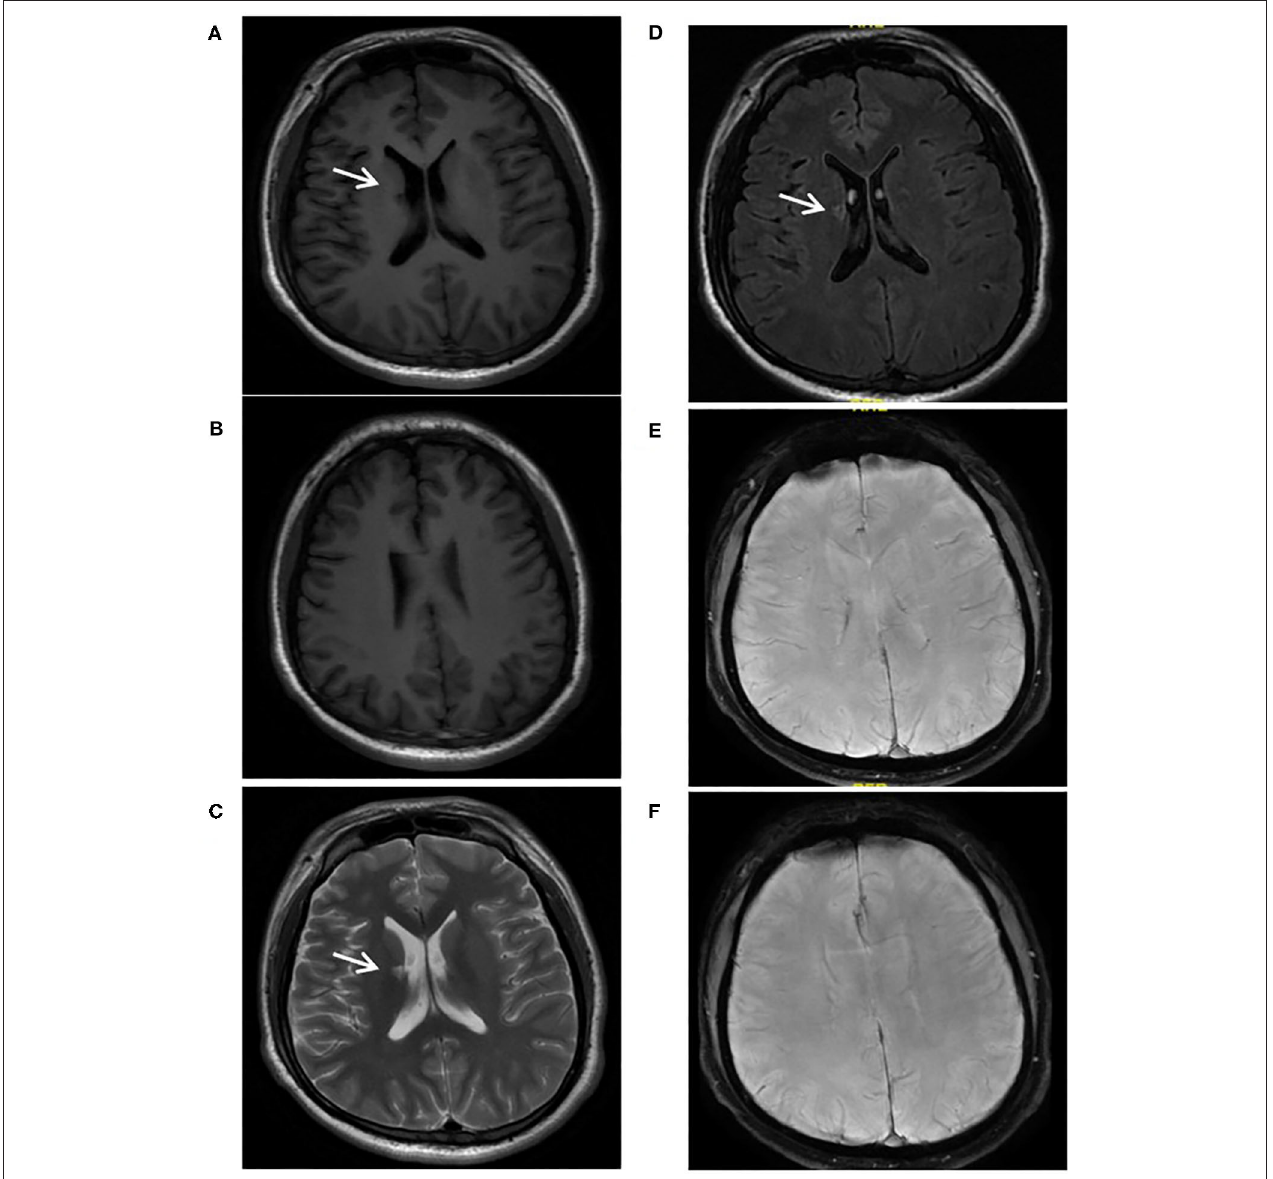
FIGURE 5 | A 24-year-old male with Sneddon’s syndrome (case 7) suffered livedo reticularis and ischemic stroke. A chronic lacune was observed in the right basal ganglion (A,C,D) . Neither chronic superficial siderosis nor cerebral microbleed was found on SWI (E,F) . No obvious atrophy or white mater hyperintensities was found (A,B)